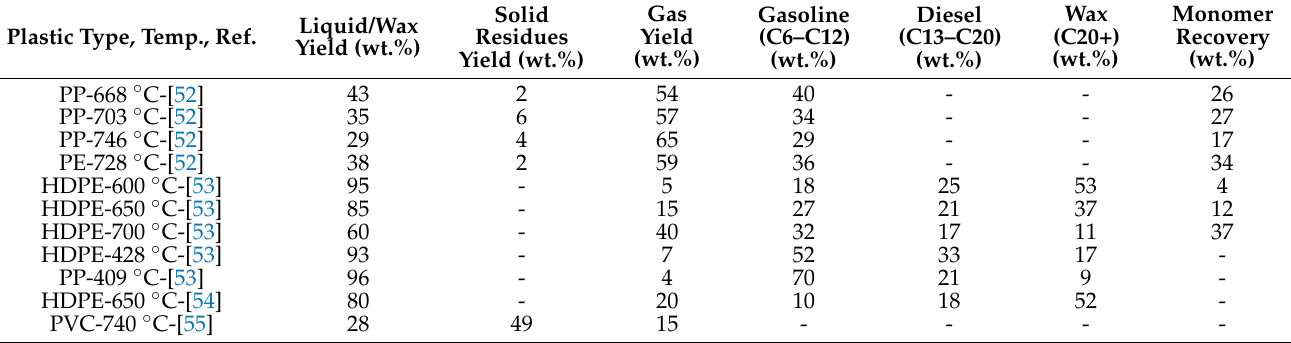
Table 4. Fast pyrolysis of different plastic